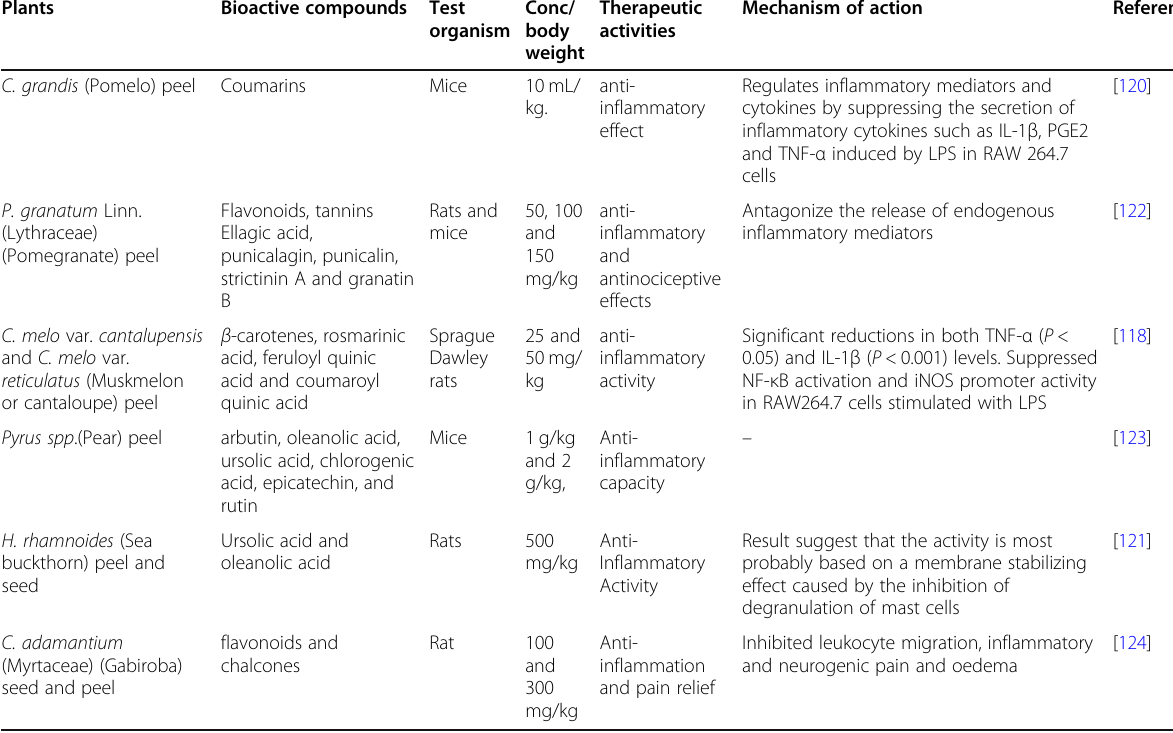
Table 7 Anti-Inflammatory Properties of Some Peels and Seed Extracts Plants